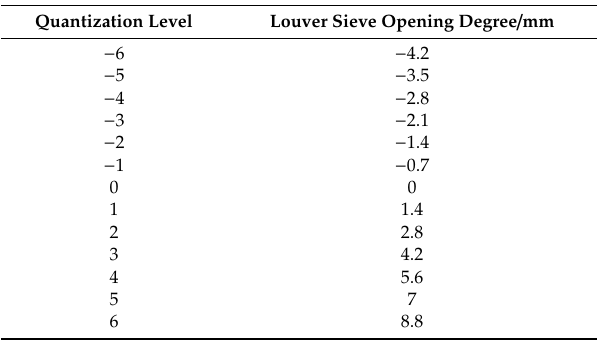
Table 3. Quantification table for louver sieve opening.